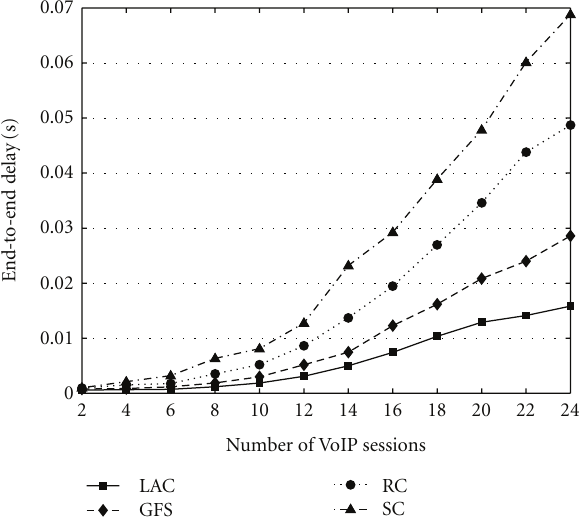
Figure 5: Average end-to-end delay with VoIP tra ffi c.